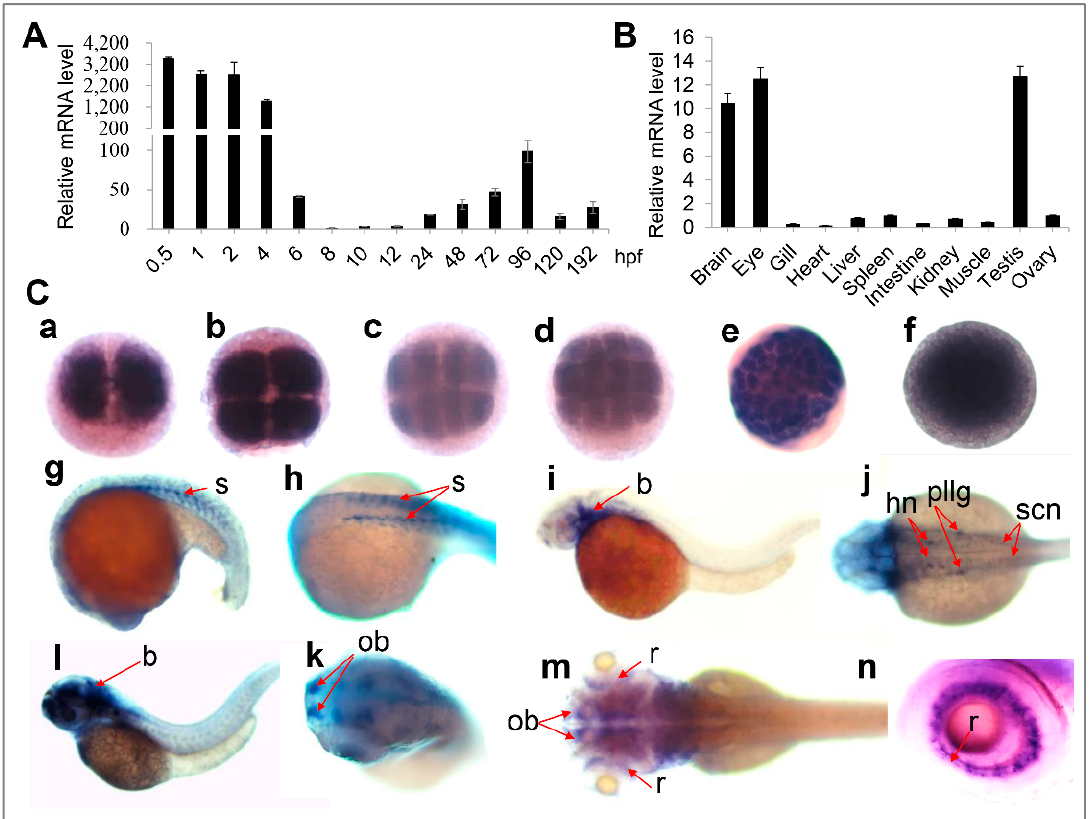
Figure 2. Expression of zebrafish oxr1a gene in different embryonic developmental stages and different tissues ( A ) qPCR analysis for the expression profile of oxr1a mRNA in wild-type (WT) embryos and larvae from 0.5 to 192 hpf. ( B ) qPCR detected the expression of oxr1a in adult tissues at 4 months old. ( C ) Whole mount in situ hybridization analysis (WISH) for the expression profile of oxr1a at: (a) two-cells; (b) four-cells; (c) eight-cells; (d) 16-cells; (e) 64-cells; (f) sphere; (g–h) 20 hpf; (i–j) 30 hpf; (l–k) 48 hpf; and (m–n) 72 hpf. The temporal and spatial expression in the somite (s), brain (b), hindbrain nuclei (hn), posterior lateral line ganglion (pllg), olfactory bulbs (ob), spinal cord neuron (scn) and retina (r) are labeled with red arrows. n = 20, and the positive rate of expression signal is about 90%.